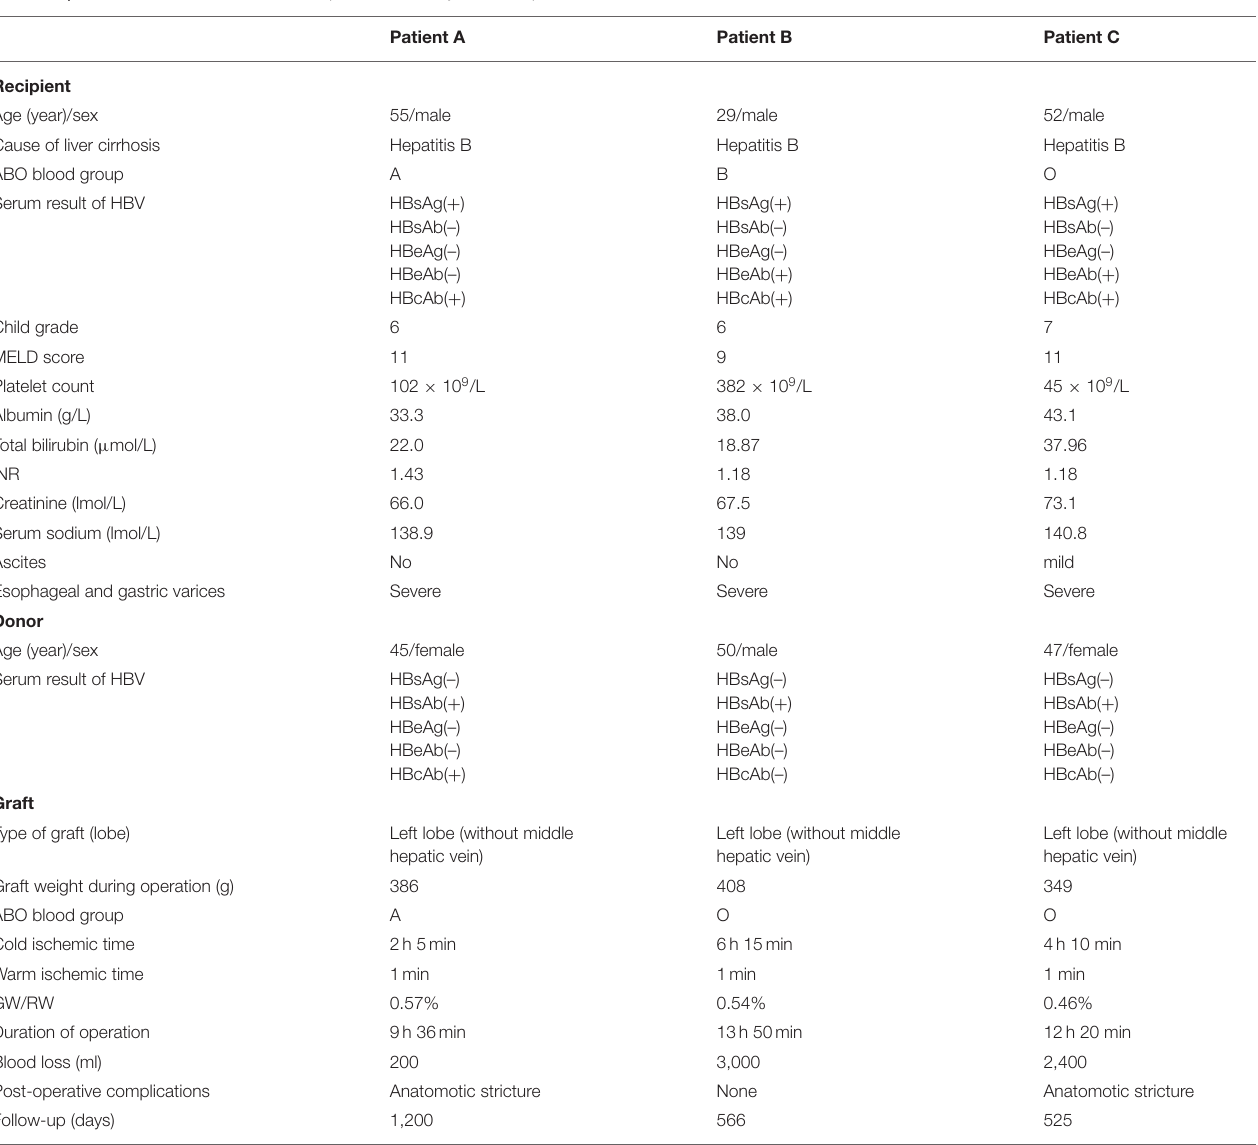
TABLE 2 | Characteristics of donors and recipients in auxiliary liver